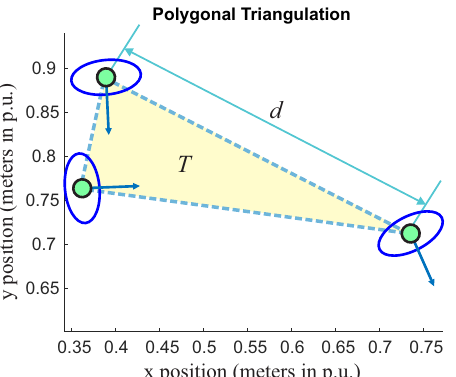
Figure 5. Distance between vertices. The yellow triangle is related to T-Space